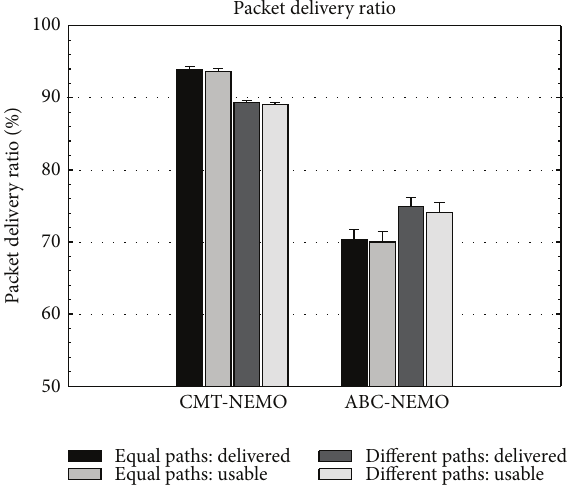
Figure 15: A comparison of packet delivery ratios at the client.